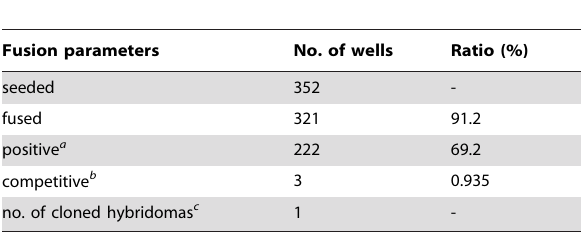
Table 2. Summary of the results of cell fusion and hybridoma